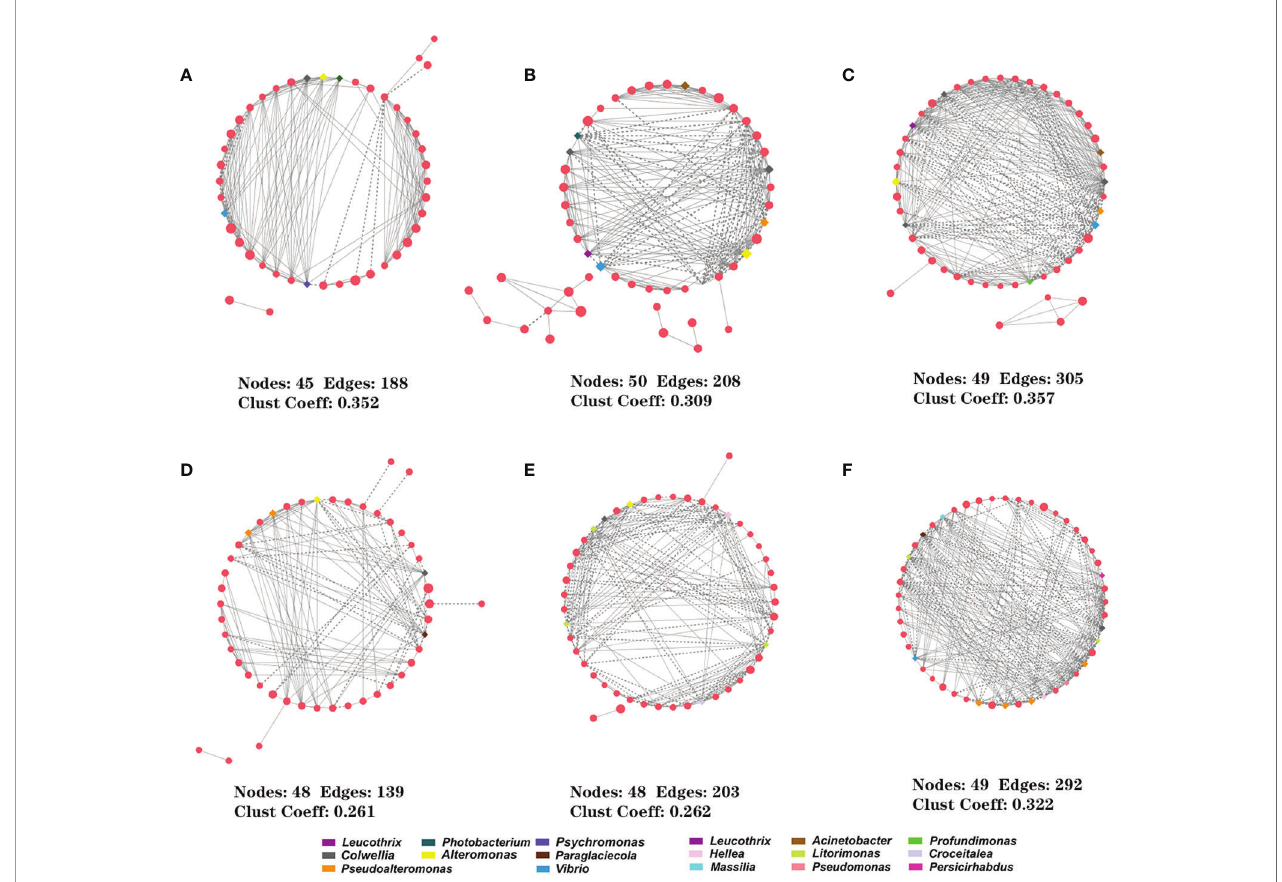
FIGURE 5 | Interspecies interactions in both control and infected groups. (A – C) control group at 4 h, 14 h and 24 h; (D – F) PpX-8 infected group at 4 h, 14 h and 24 h. The solid (or dashed) represents the positive (or negative). The squares represent keystone